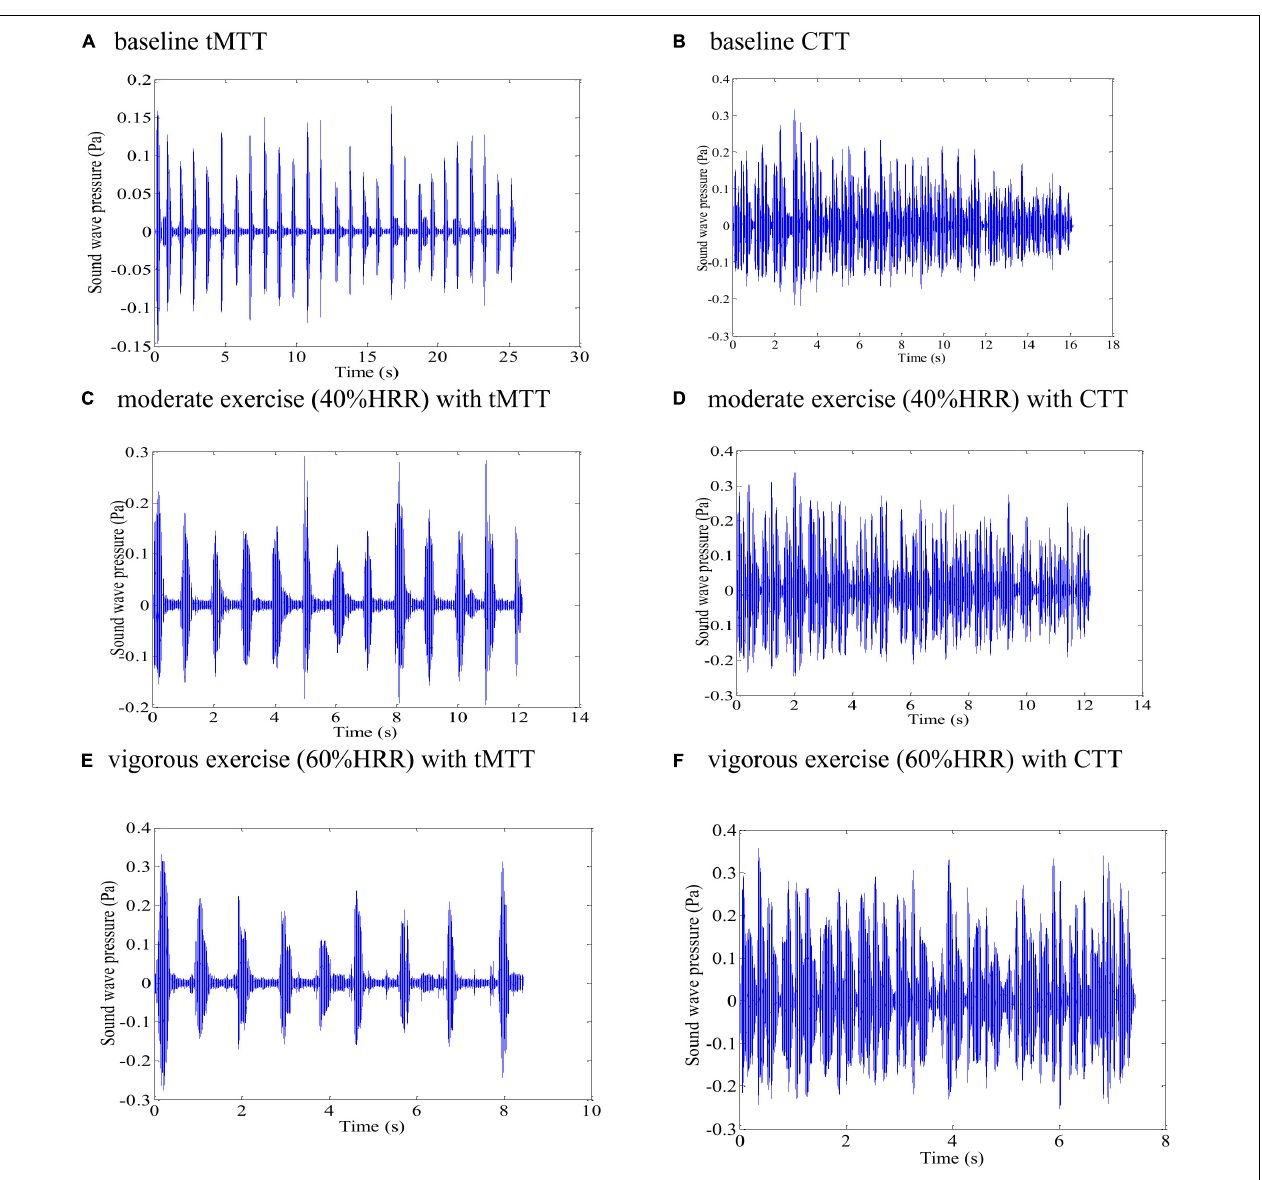
FIGURE 3 | Different patterns of speech signals from one of the participants when producing tMTT versus CTT utterances over time within a single breath at various exercise stages: (A) baseline tMTT, (B) baseline CTT, (C) moderate exercise (40%HRR) with tMTT, (D) moderate exercise (40%HRR) with CTT, (E) vigorous exercise intensity (60% HRR) with tMTT, and (F) vigorous exercise intensity (60% HRR) with